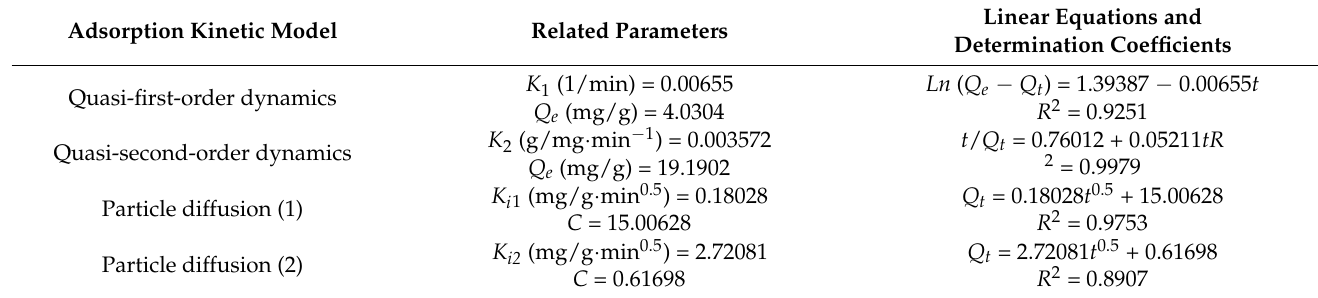
Table 1. Parameters reflecting the sorption kinetics, calculated using the kinetic